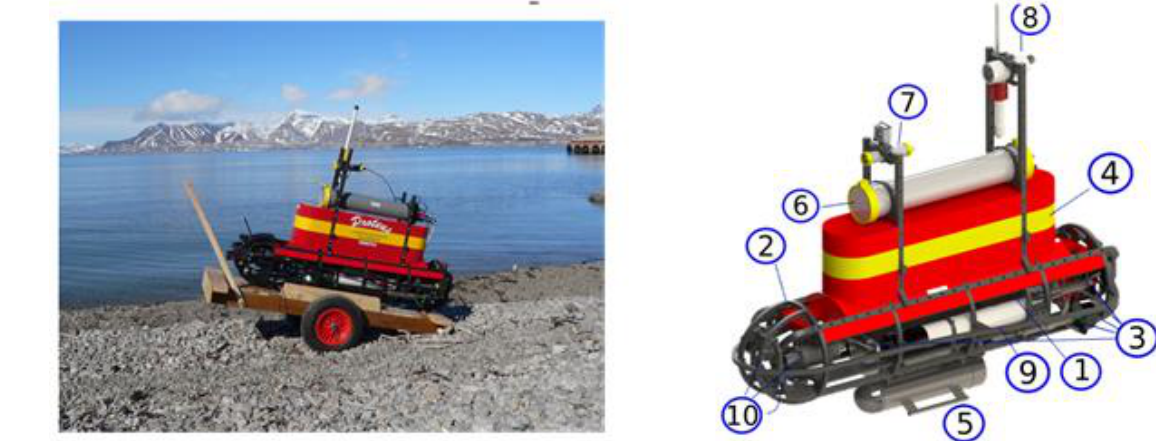
Figure 3. ( Left ): Picture of PROTEUS (Portable RObotic TEchnology for Unmanned Surveys) in Ny Alesund. ( Right ): PROTEUS components: 1—control system in a pressure-tight canister; 2—shockproof frame of polyethylene; 3—thrusters; 4—removable foam; 5—battery pack for USSV operations; 6—surface control unit, GPS, and inertial sensors; 7—cameras; 8—communications, Wi-Fi antenna, and auxiliary ethernet cameras; 9—multi-probe CTD; 10—front sensors, such as turbidimeter, fluorimeter, and altimeter.